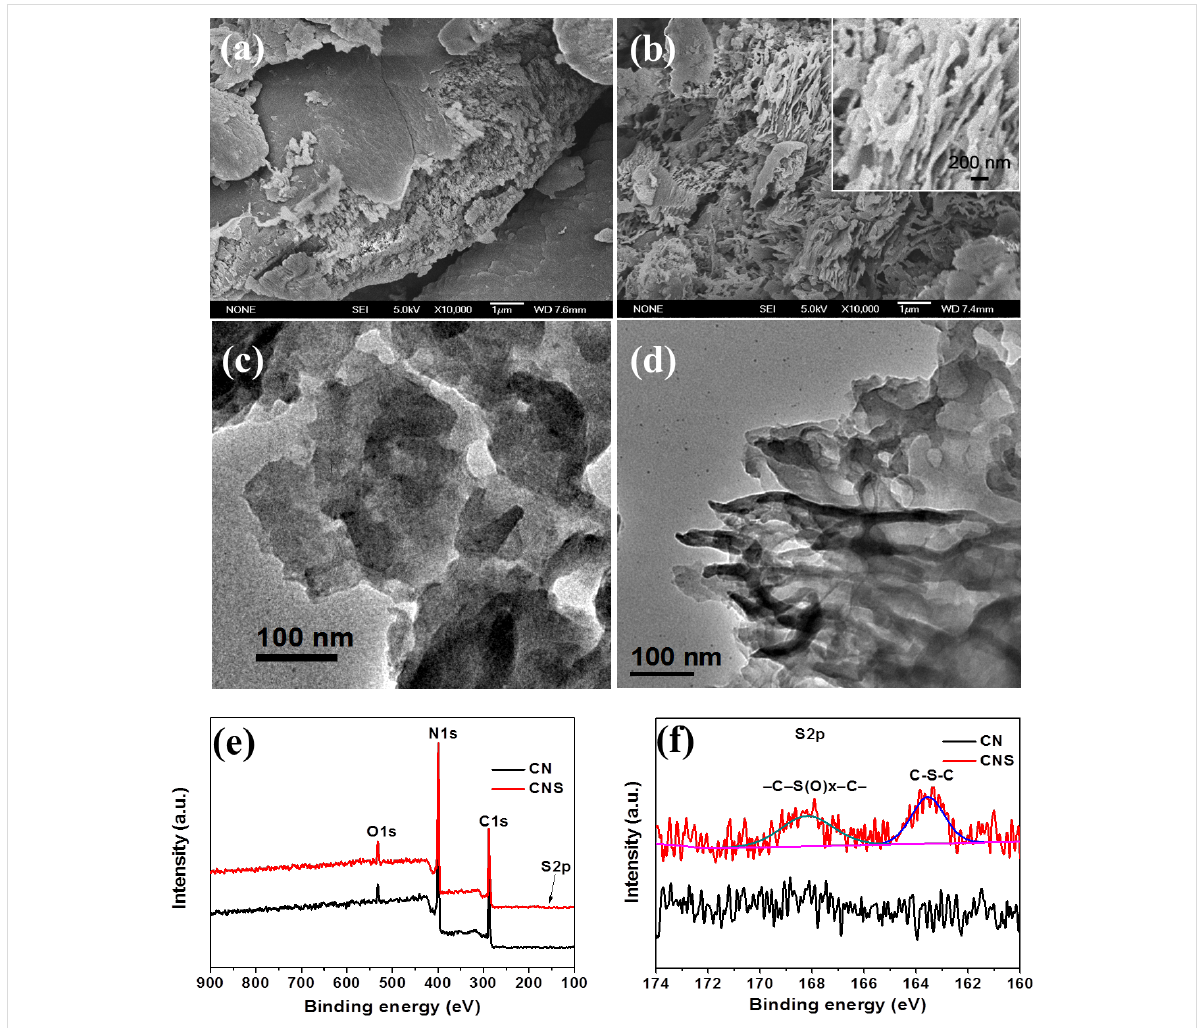
Figure 1: FESEM and TEM images of (a,c) CN, and (b,d) CNS samples. The inset of (b) is an enlarged FESEM image of the CNS sample. (e,f) Survey XPS spectra and high-resolution S2p XPS spectra of CN and CNS samples.